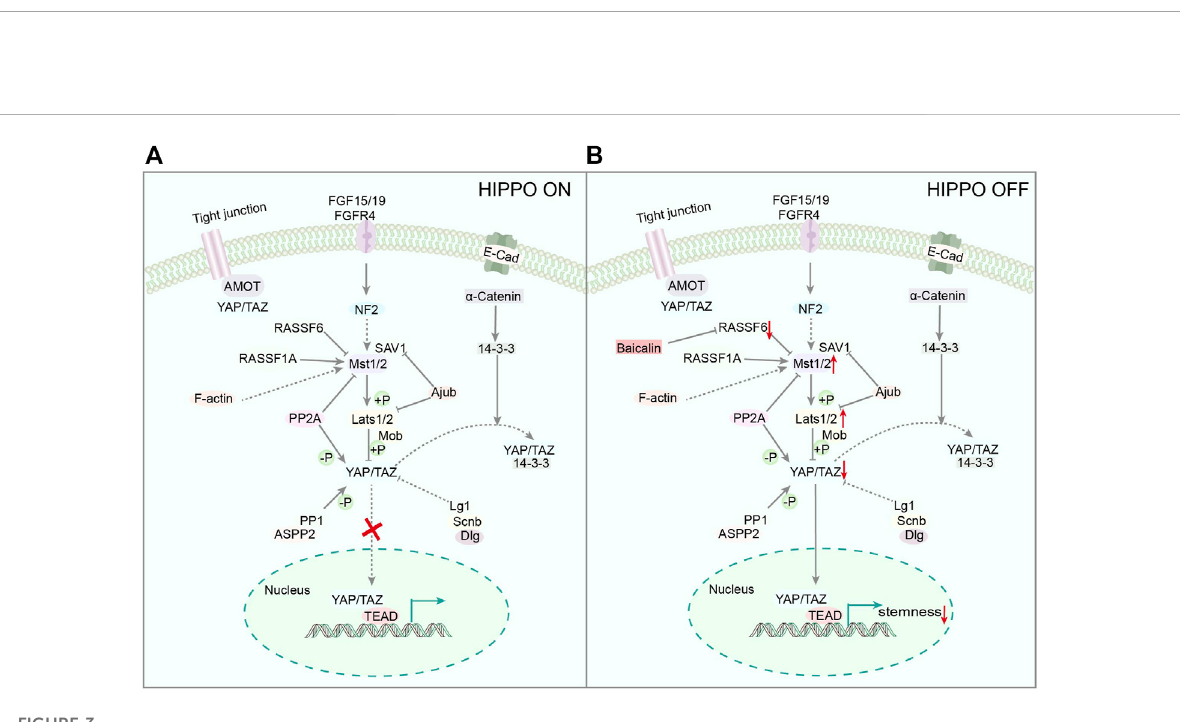
FIGURE 3 (A) Representative scheme illustrating the Hippo Signaling pathway. (B) Representative scheme illustrating Baicalin ’ s role in the proliferation of CSCs by regulating the Hippo Signaling